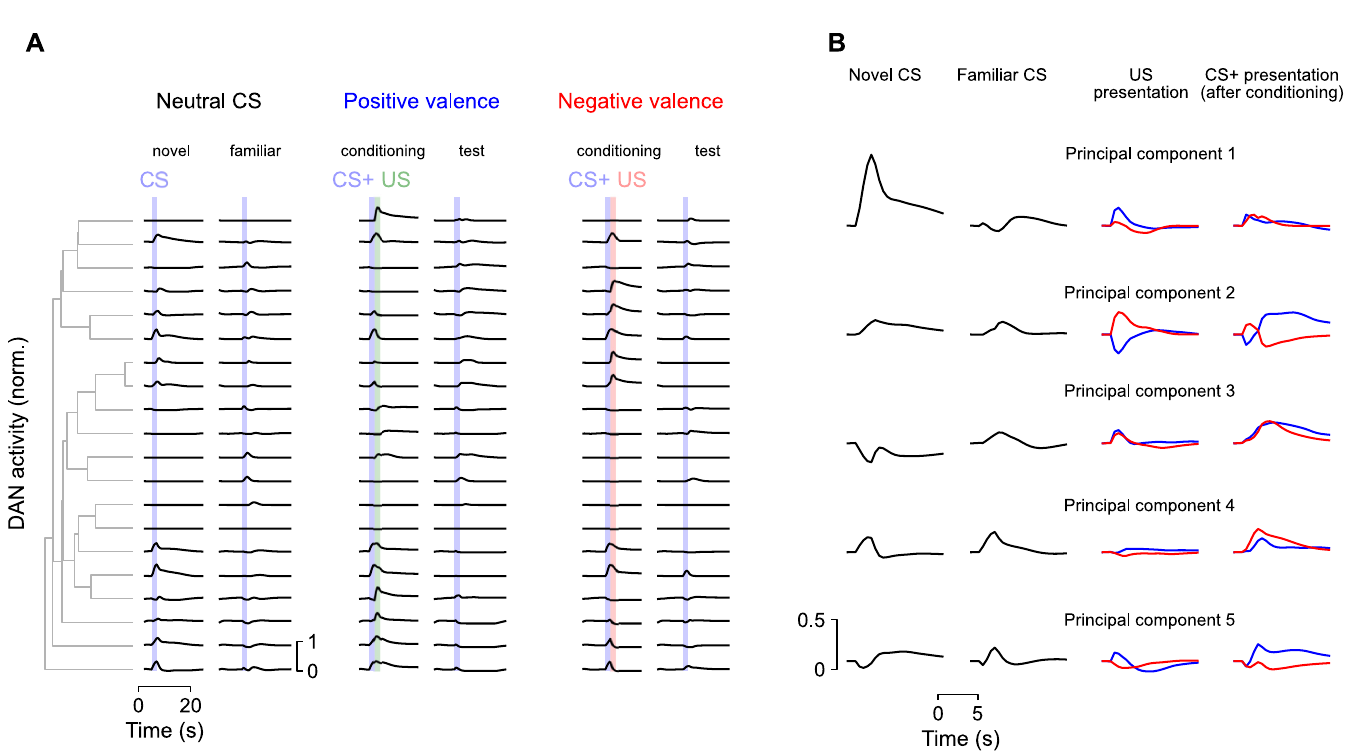
Fig 6. Behavior of a network that encodes both valence and novelty. The network is similar to Fig 5 but a second readout that computes novelty is added. The novelty readout is active for the first presentation of a given CS and zero otherwise. (A) The addition of novelty as a readout dimension introduces dopamine neuron responses that are selective for novel CS. Compare with Fig 5B. (B) The first principal component (PC1) for the network in A is selective for CS novelty. Compare with Fig